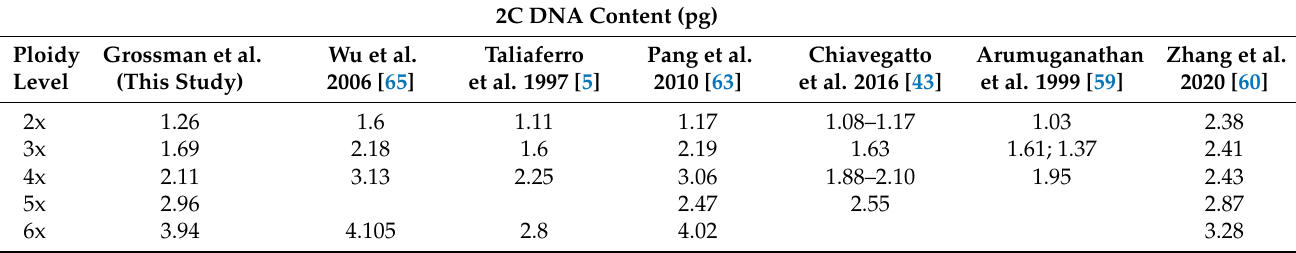
Table 4. Comparison of average genome size (pg/2C DNA) per ploidy level for six different studies including bermudagrass accessions.